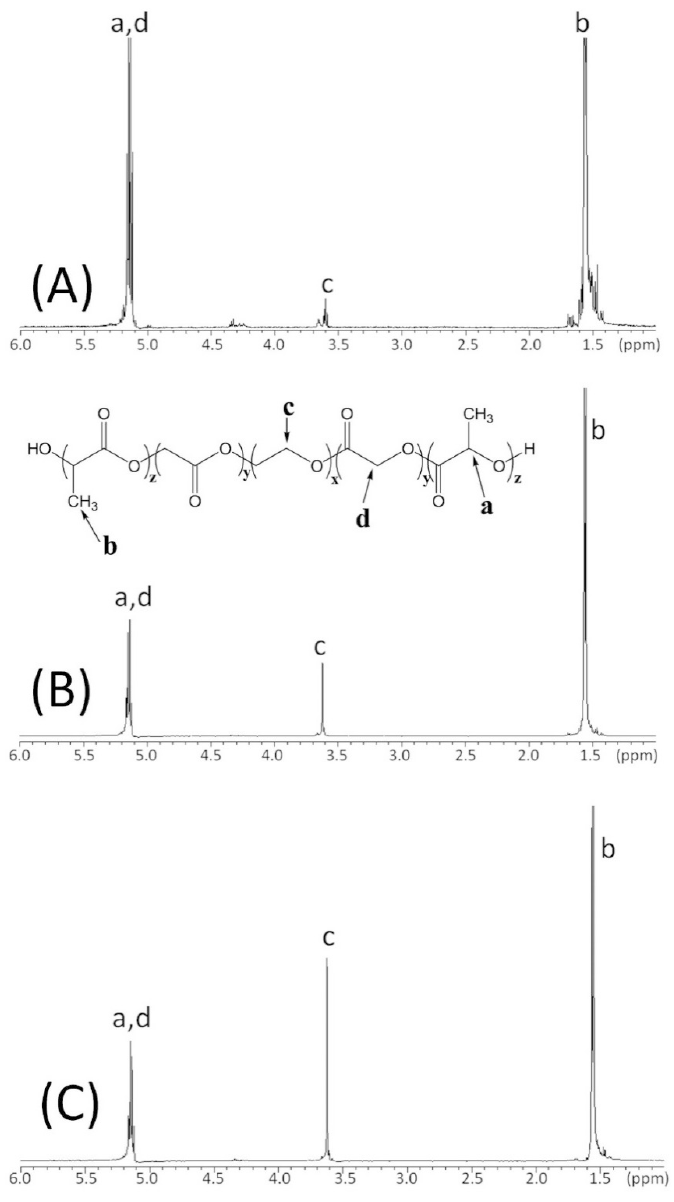
Figure 1. 1 H-NMR spectra of ( A ) PLLA-PEG200; ( B ) PLLA-PEG1000; ( C ) PLLA-PEG2000. Figure 2a–c indicate PEG1000, PLLA, and PLLA-PEG1000 infrared spectroscopy, respectively. The C=O stretching vibrational absorption of the ester functional group of PLLA appeared at 1757 cm − 1 ; -CH 3 stretching vibrational absorption of PEG showed between 3000 and 2800 cm − 1 . According to Figure 2c, PLLA-PEG1000 infrared spectros- copy and 1 H-NMR spectroscopy could figure out that the series of syntheses of the PLLA-PEG block copolymer was successful. Moreover, following the frequency of the 1H-NMR quantity, the relative abundance ratio would be found out: PLLA and PEG200 with a ratio of 12/1, PLLA and PEG1000 with a ratio 8/1, and PLLA and PEG2000 with a ratio of 5/1.